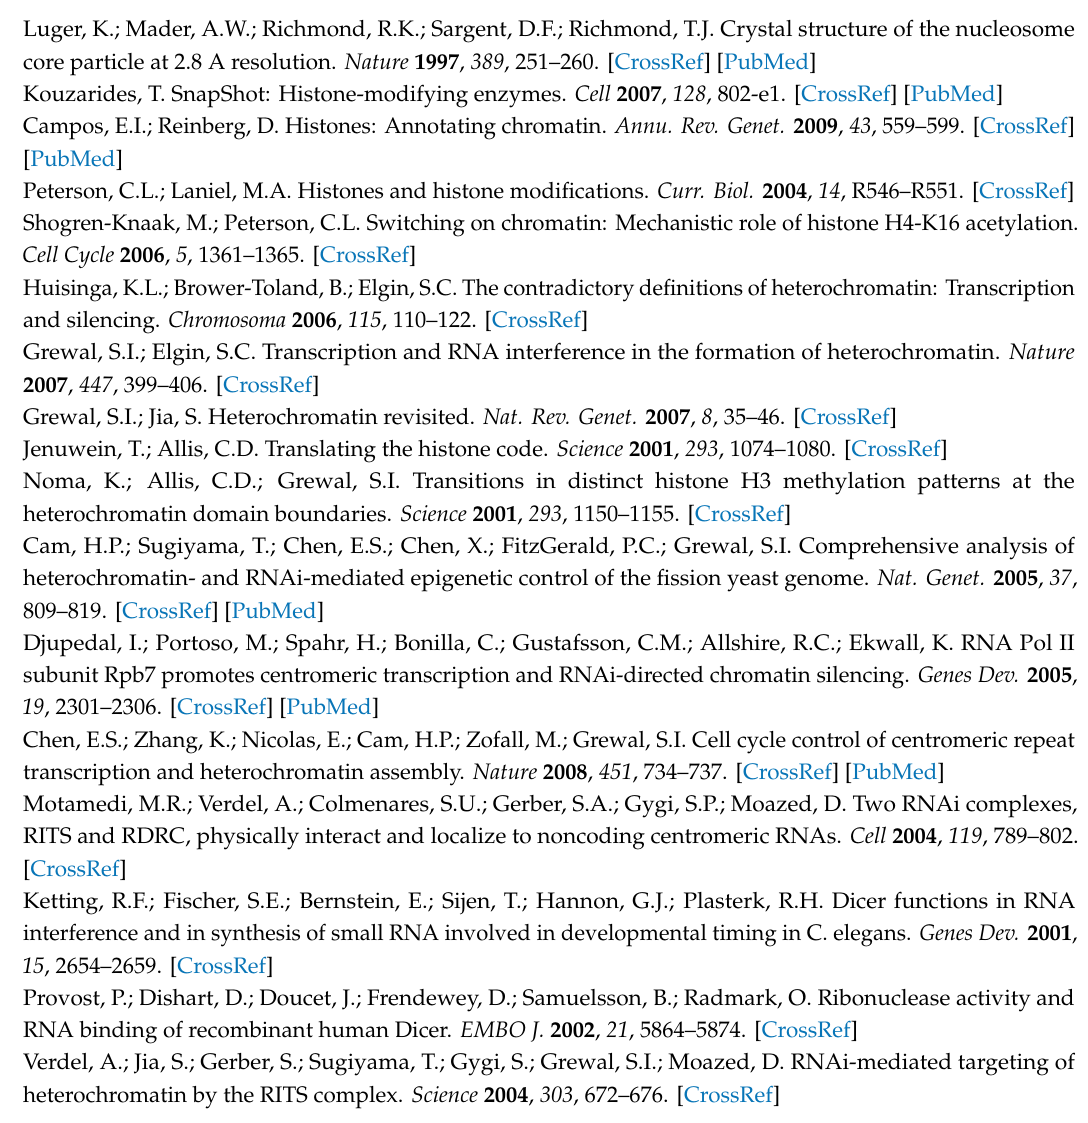
Supplemental Table S1: A list of stains used in this study. Supplemental Table S2: A list of oligos used in this study. Supplemental Table S3: A list of DEG in lsd1- ∆ HMG and lsd2- ∆ C